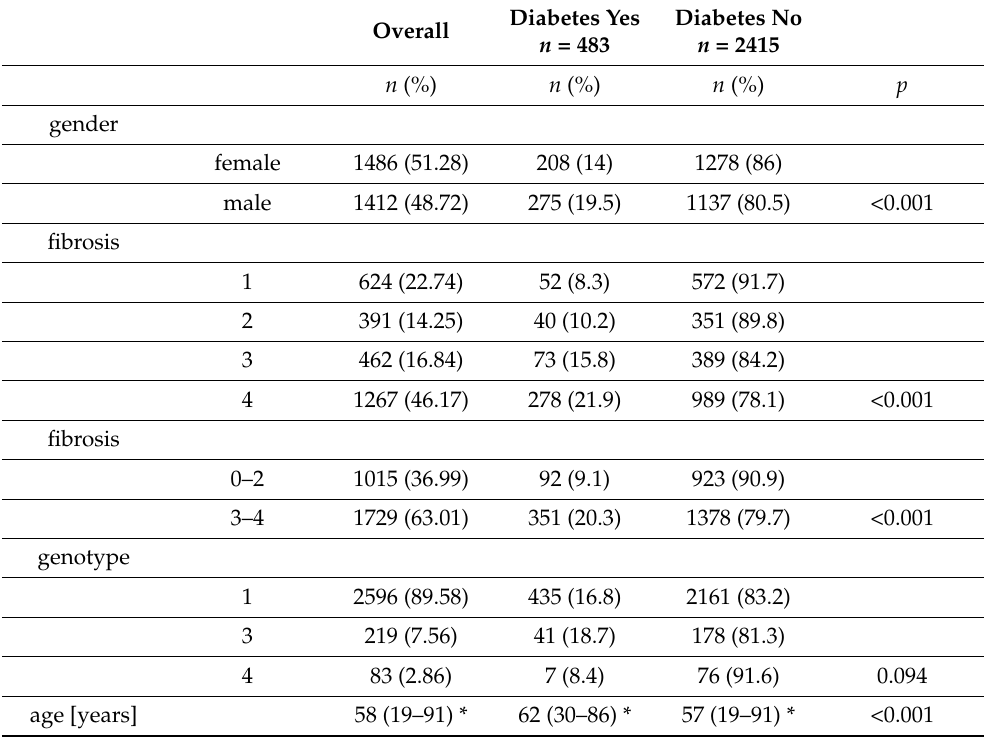
Table 3. The characteristics of patients and the incidence of diabetes.